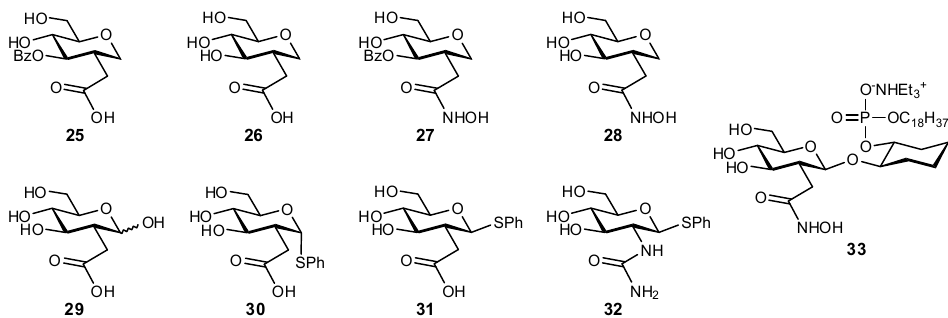
Figure 11. A series of 2-deoxygenated 2- C -modifed glucosides containing Zn 2+ -chelating groups were synthesized and evaluated as inhibitors of Trypanosoma brucei N -acetylglucosamine- phosphatidylinositol de- N -acetylase as a potential novel therapy for African sleeping sickness [151] .